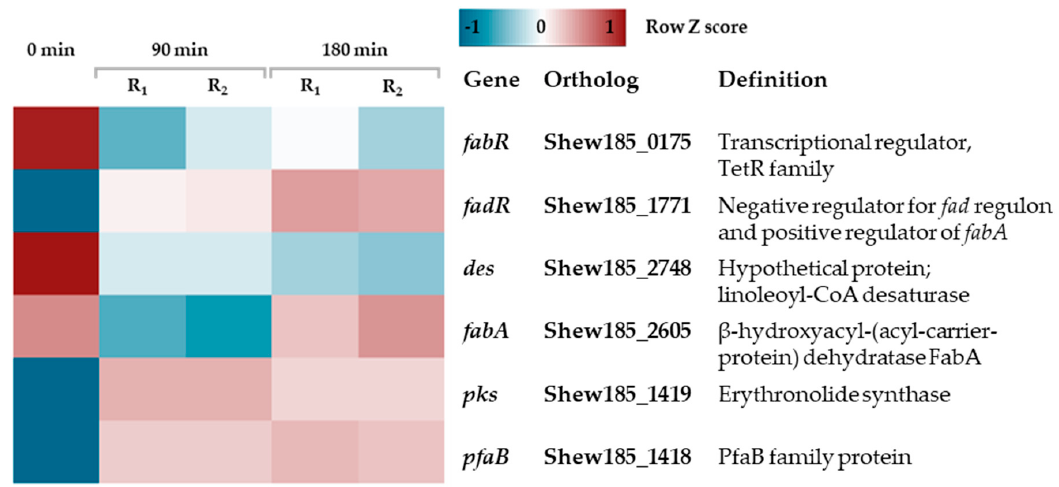
Figure 6. Expression changes in S. baltica fatty acid metabolism upon cold stress. Heatmap showing row Z-score scaled normalized expression for corresponding genes. Column 0 stands for control sample; replicates for 90 and 180 min time points are labeled R 1 and R 2 .